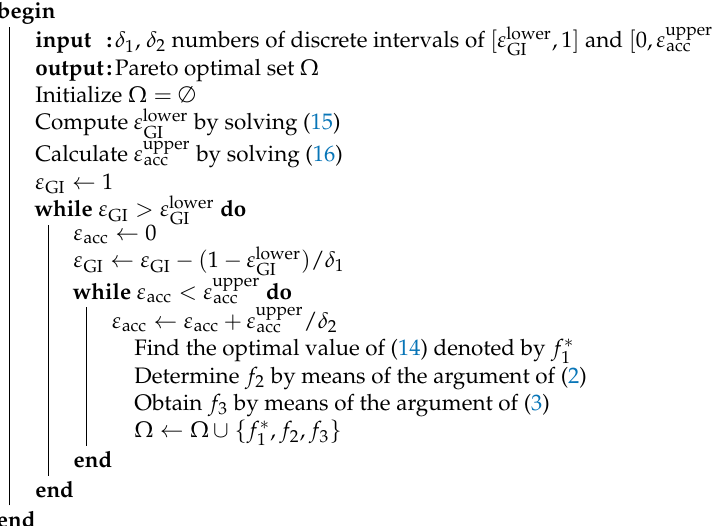
Algorithm 1 ε -constraint approach for obtaining the Pareto optimal set of the multi- objective mathematical